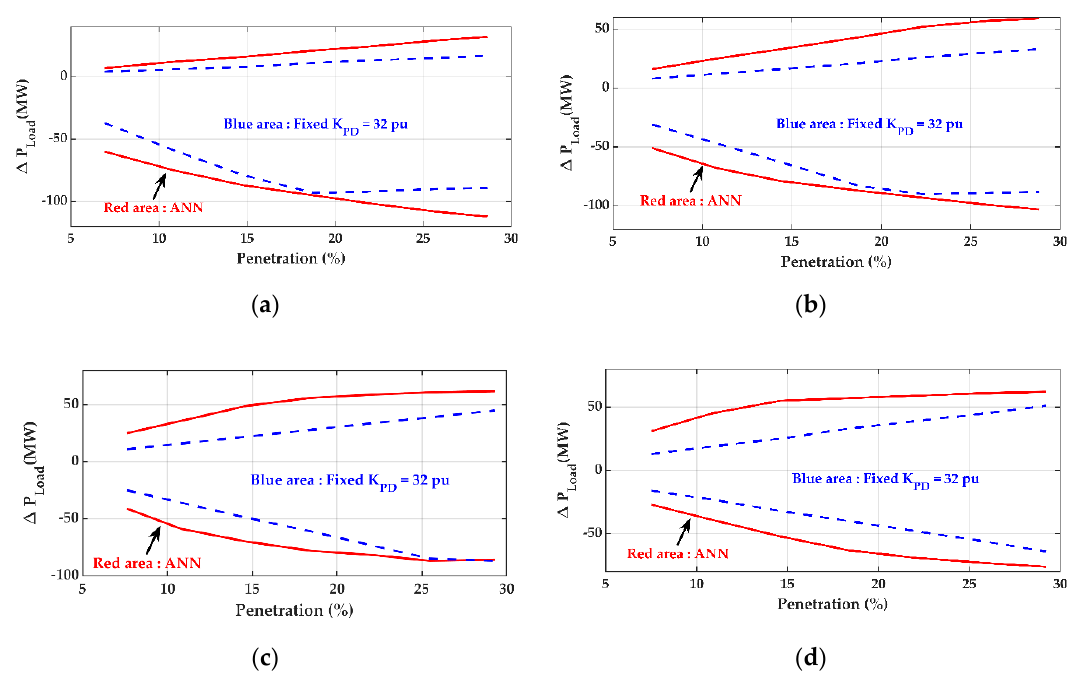
Figure 16. Comparison of the feasible operating regions for the ANN-based controller and fixed-gain controller. ( a ) V W = 9 m/s, ( b ) V W = 10 m/s, ( c ) V W = 11 m/s, and ( d ) V W = 12 m/s.